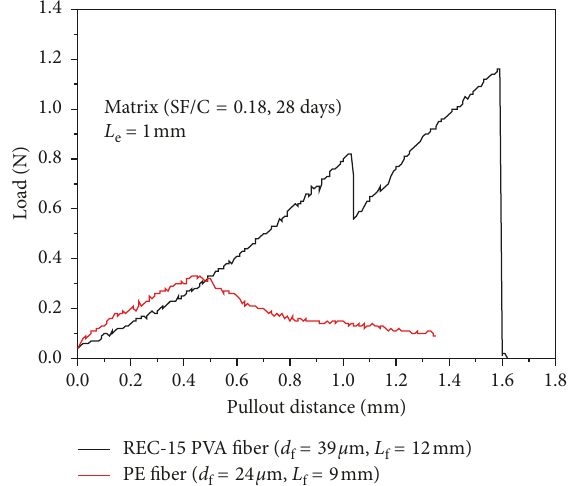
Figure 6: Tensile behaviors of the controlled mixture ECC1 with local ingredients and imported fiber